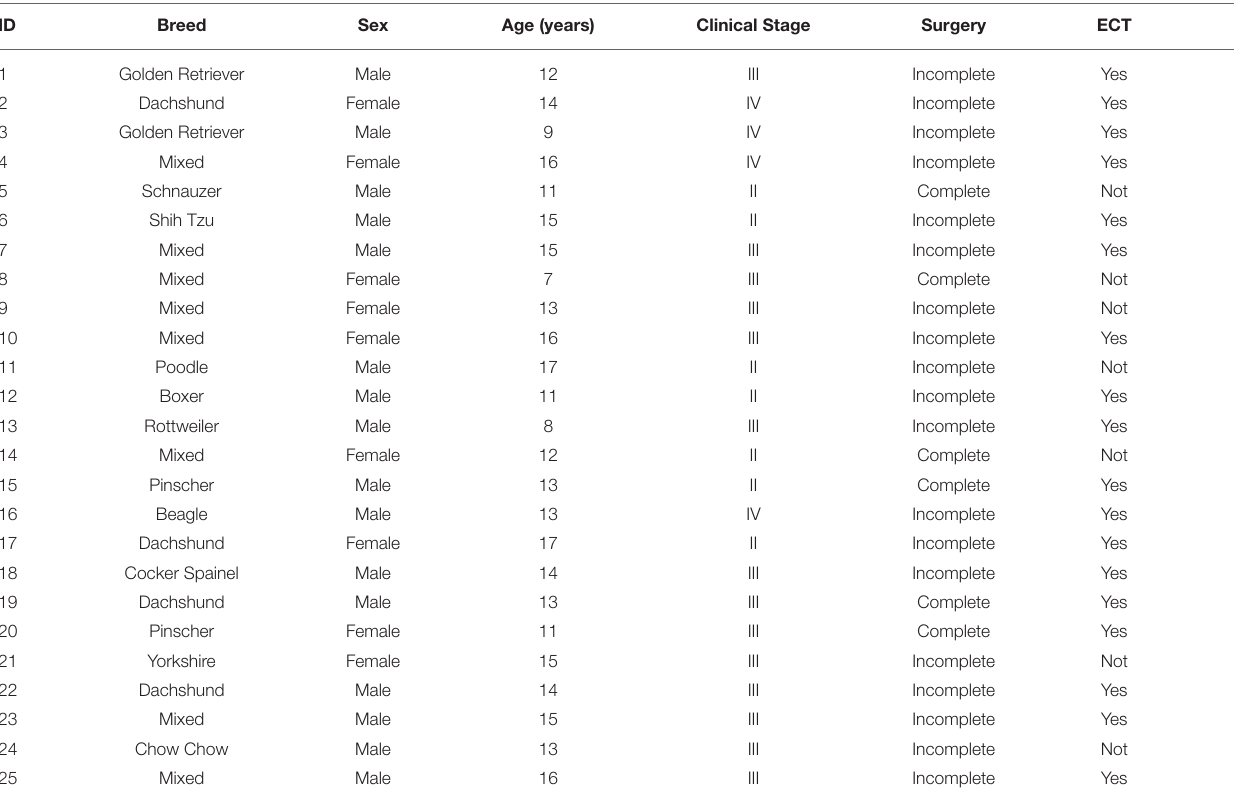
TABLE 1 | Characterization and treatment of 25 dogs with oral melanoma.